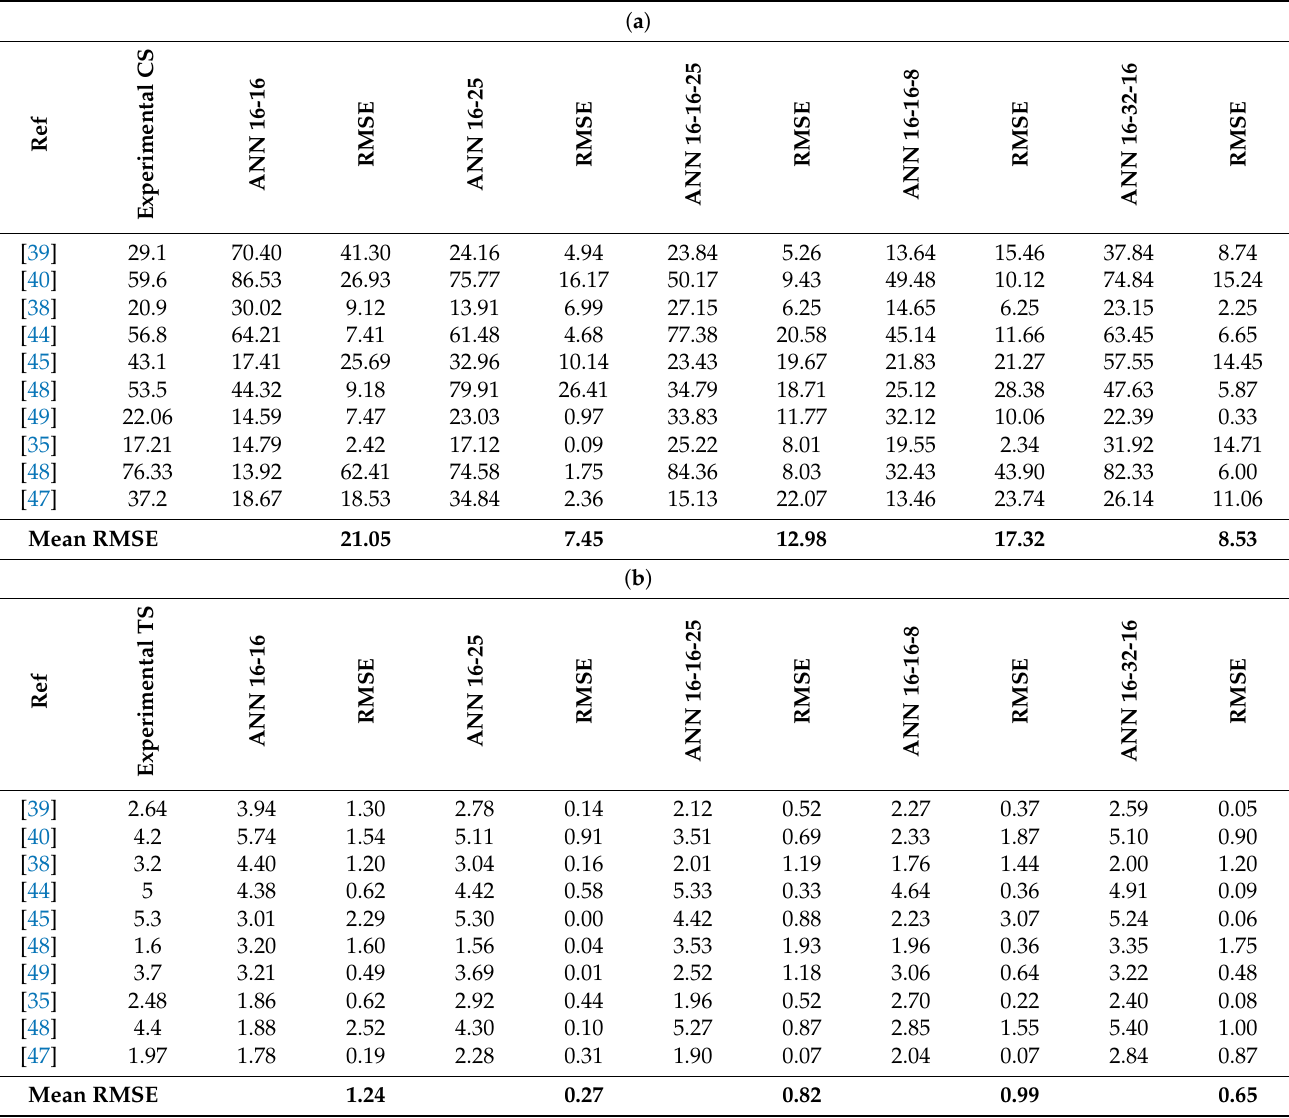
Table 7. ( a ) Cross-validation of ANN-I models upon the prediction of compressive strength; ( b ) cross- validation of ANN-I models upon the prediction of tensile